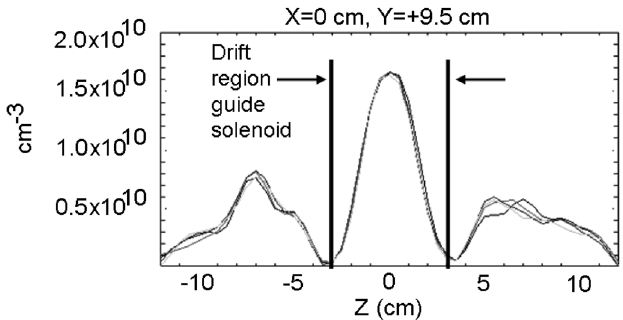
at late times ( t (cid:6) p